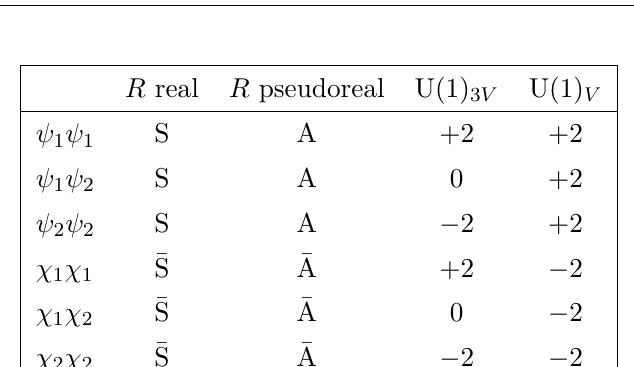
× U(1) are accidentally 3 V V